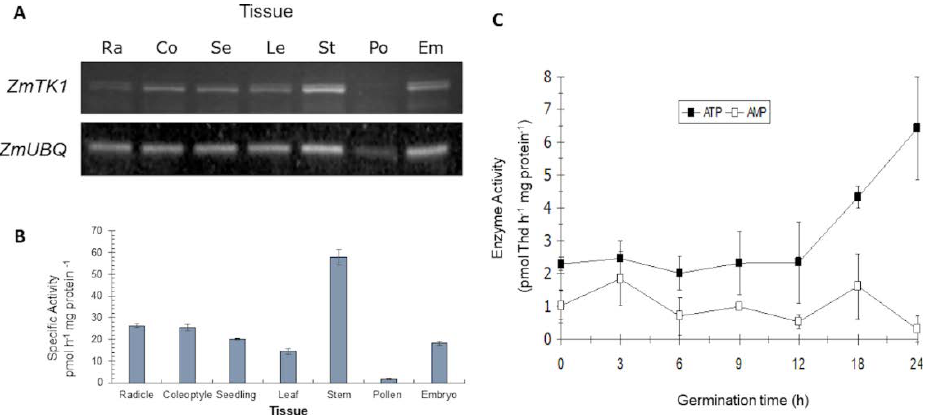
Figure 1. ZmTK1 transcript and enzymatic activity are ubiquitously present during maize development. ( A ) Transcript levels of ZmTK1 in radicles of 2 days seedlings (Ra), coleoptiles of 5-day seedlings (Co), 10-day-old seedlings (Se), leaf (Le) and stem (St) of 20-day-old plants, dehiscent pollen (Po) and mature embryos (Em). Ubiquitin transcript used as a loading control. ( B ). Thymidine kinase enzymatic activity in the same maize tissues. ( C ) TK activity and non-specific phosphotransferase (NSPT) activity during maize germination. For Figure 1B,C, values represent average ± standard deviation of three technical repeats from three independent protein extracts replicates.